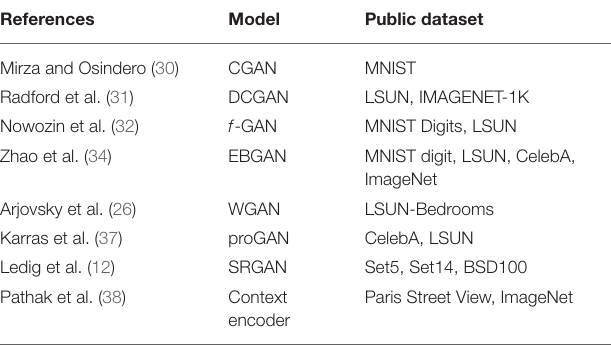
TABLE 1 | Literatures for the application of GAN in image